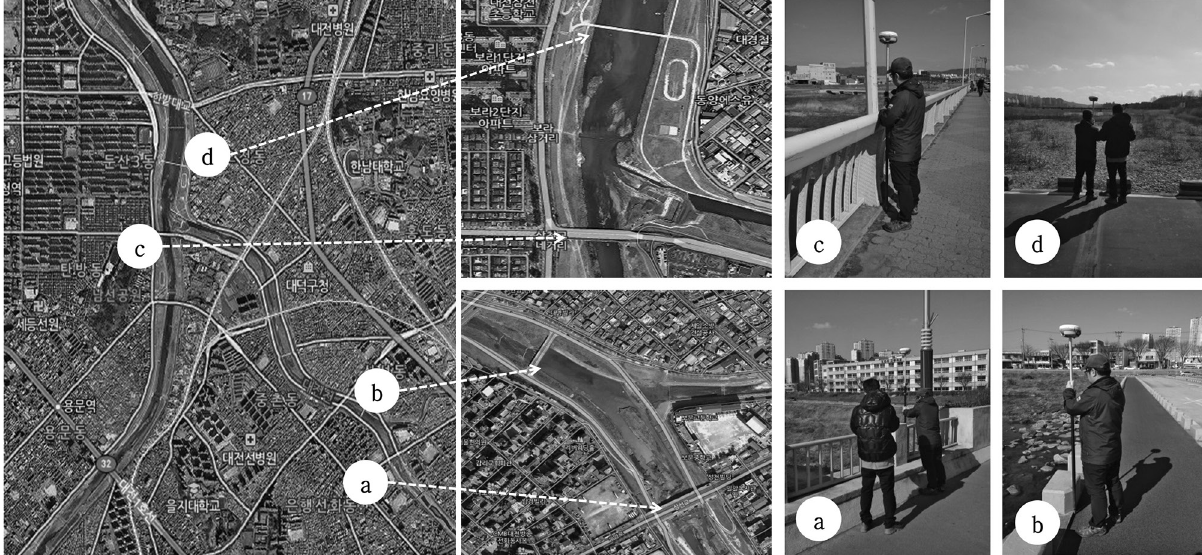
Figure 2. The study area in satellite image along with digital image while surveying (a) Samseon-gyo, (b)